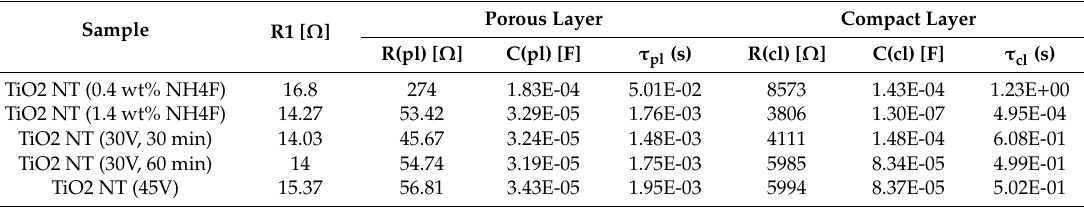
Table 1. Circuit components calculated by fitting the experimental impedance